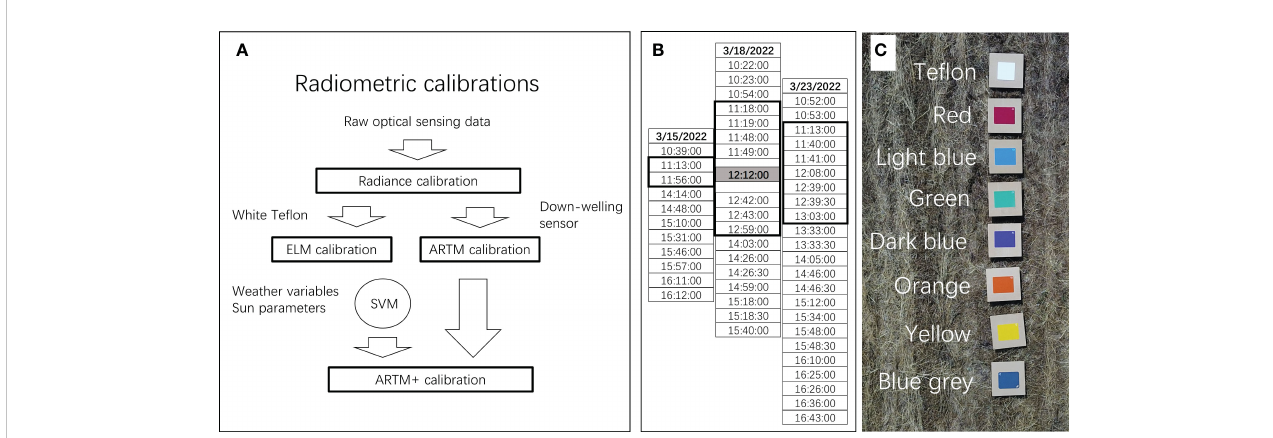
FIGURE 2 Illustration of data work fl ow related to radiometric calibration of optical sensing data (A) . Time of 52 fl ight missions on three separate days (B) . Optical sensing data acquired during one fl ight mission (Day 2, 12:12) is highlighted as it was used as to develop classi fi cation functions (one for each level of radiometric calibration), which were applied to the remaining 51 optical sensing data sets. Experimental objects (white Te fl on and seven colored panels) placed on top of wooden boards and imaged during 52 fl ight missions (C)